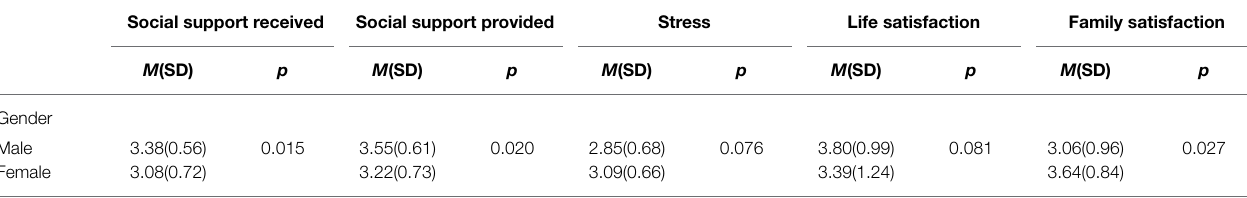
TABLE 3 | Mean differences in social support, stress, life satisfaction and family satisfaction according to the gender of the parent.